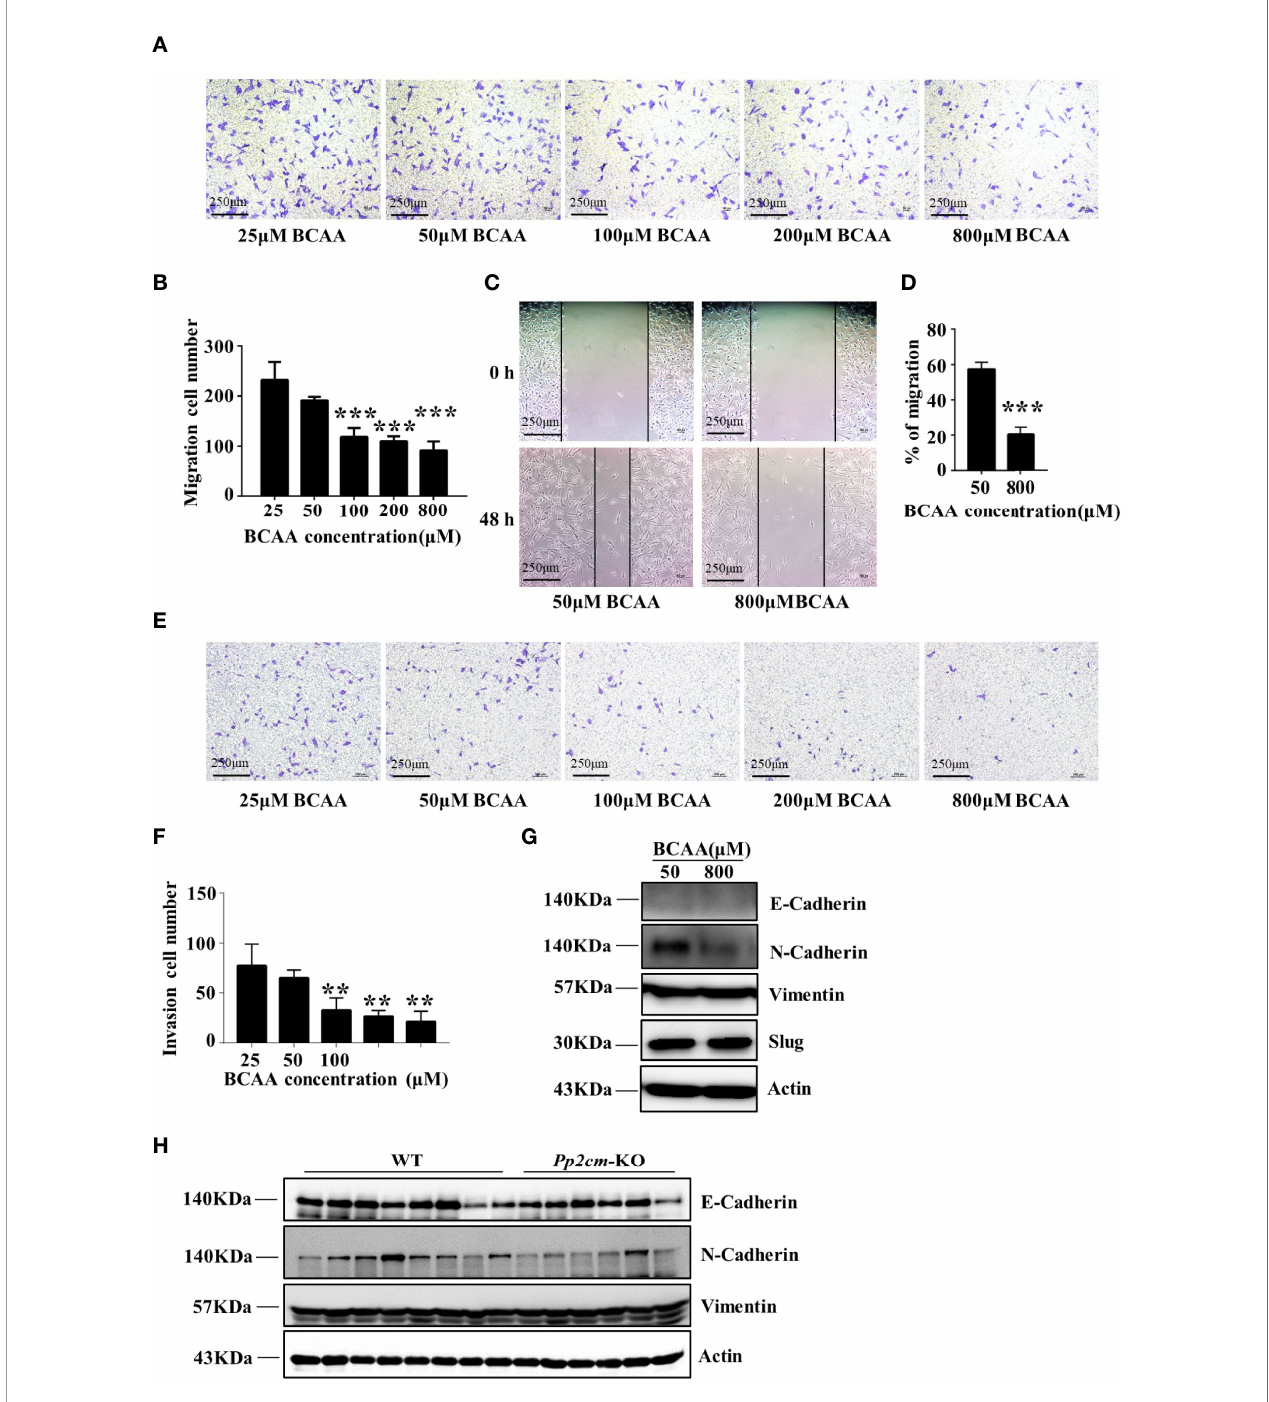
FIGURE 6 | High BCAA inhibits the ability of breast cancer cell migration, invasion, and the expression of N-Cadherin. (A) Migration ability of LM2 cells treated with different concentrations of BCAA analyzed by transwell assay (22 hours). (B) Statistics of the number of migration cells in transwell assay. All BCAA treated groups (50 m M, 100 m M, 200 m M, 800 m M) were compared with 25 m M BCAA group. ***p < 0.001, one-way ANOVA. (C) Wound healing assay was used to detect the migration ability of LM2 cells treated by different concentrations of BCAA (48 hours). (D) Statistics of the mobility ratio in wound healing assay. (E) Invasion ability of LM2 cells treated by different concentrations of BCAA was detected by transwell assay (22 hours). (F) Statistics of the number of invasion cells in transwell assay. All BCAA treated groups (50 m M, 100 m M, 200 m M, 800 m M) were compared with 25 m M BCAA group. **p < 0.01, ANOVA. (G) N-Cadherin, E-Cadherin, Vimentin, and Slug expression was analyzed by Western blot in LM2 cells. (H) E-Cadherin, N-Cadherin, and Vimentin expression in tumor tissues was detected by Western